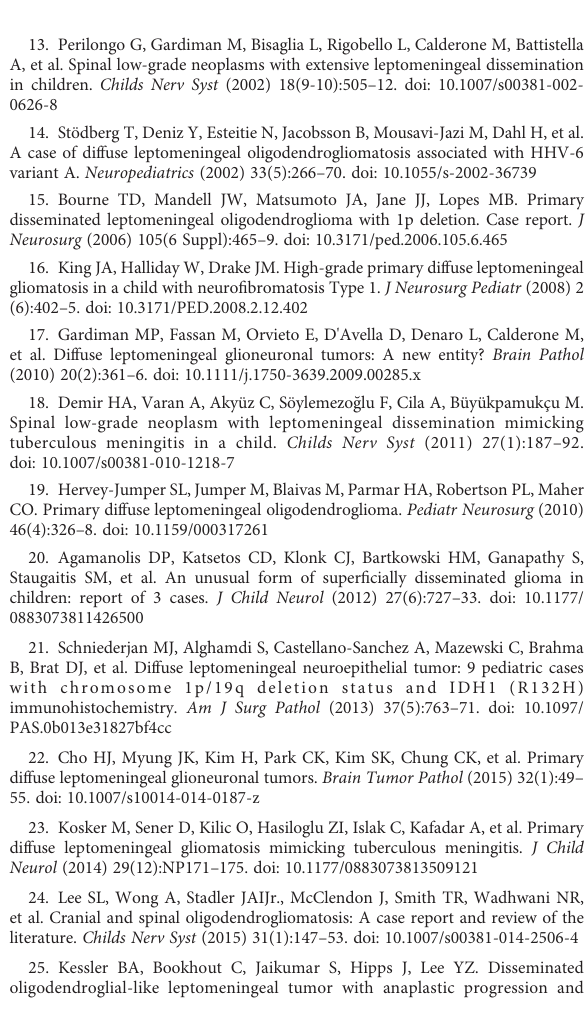
SUPPLEMENTARY FIGURE 1 Radiological features of 3 representative cases of DLGNTs. [DLGNT-MC- 1_10 (A-C) , DLGNT-MC-2_09 (D, E) , DLGNT-MC-2_03 (F) ]. Multicystic lesions with nodular enhancement in the cerebellum and cervical spinal cord spanning with leptomeningeal enhancement covering the cerebellum. Reproduced with permission from Springer Nature. Deng MY, Sill M, Chiang J, et al. Molecularly de fi ned diffuse leptomeningeal glioneuronal tumor (DLGNT) comprises two subgroups with distinct clinical and genetic features. Acta Neuropathol